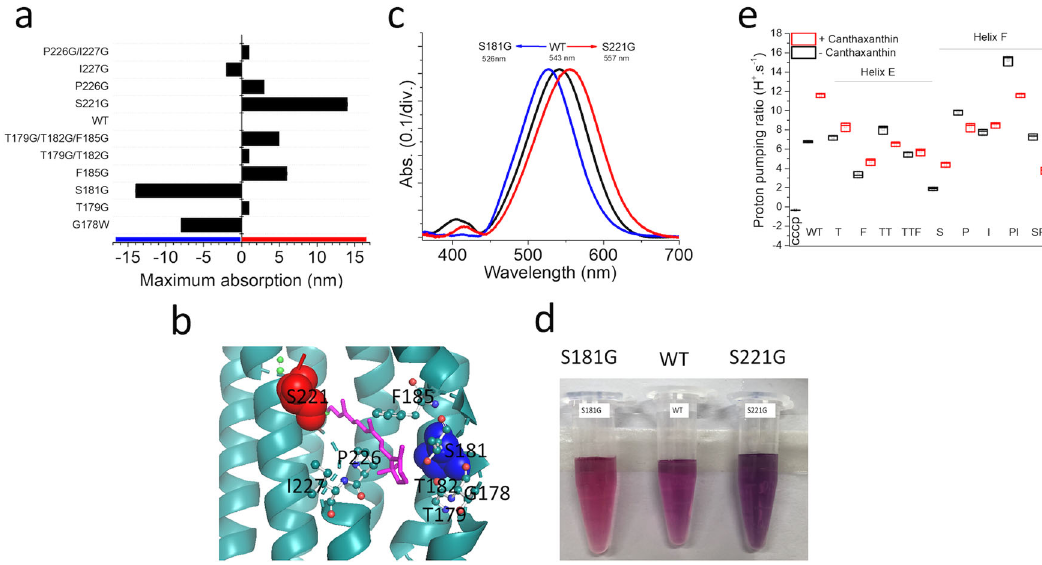
Fig. 2 Structural-based alteration of targeting mutants and the interaction of the retinal and carotenoid chromophores. a Maximum absorption shifted of targeted mutants. b The local view of mutation position shows in the red sphere Ser 221 for the strongest red-shifted and the blue sphere for Ser 181 for the strongest blue-shifted. c UV – vis spectra of wild type, S181G, and S221G. d Puri fi ed samples in 0.02% DDM. e Comparison of proton pumping with and without carotenoid, helix E mutants showed a reduction of proton pumping enhancement as a response to lower binding ration; however, helix F mutants with higher carotenoid binding ratio disrupted the bene fi t of carotenoid in proton pumping, suggesting the challenge of energy transfer and light absorption.